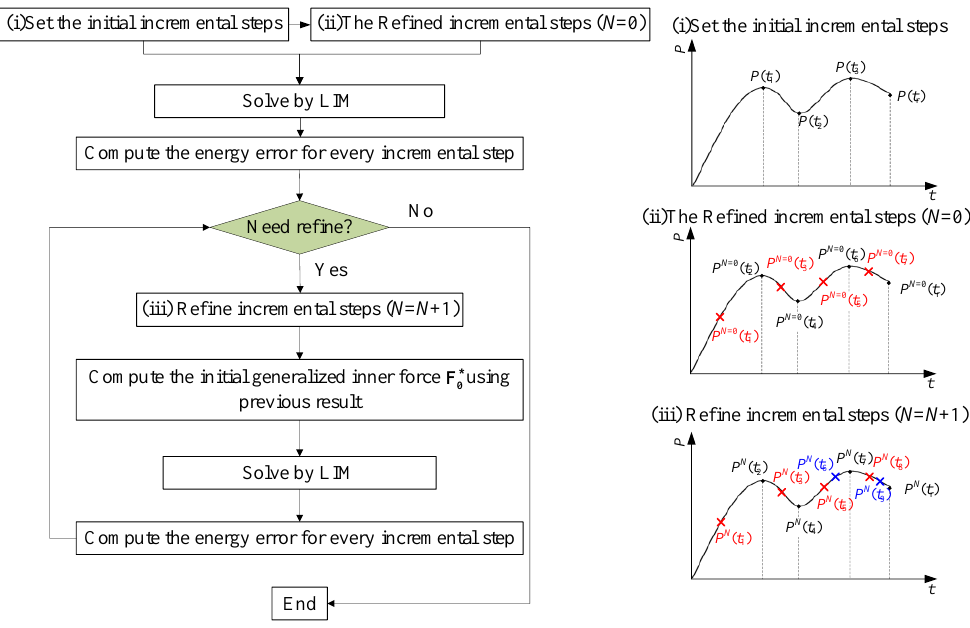
Figure 2. Adaptive load incremental step procedure of LIM.